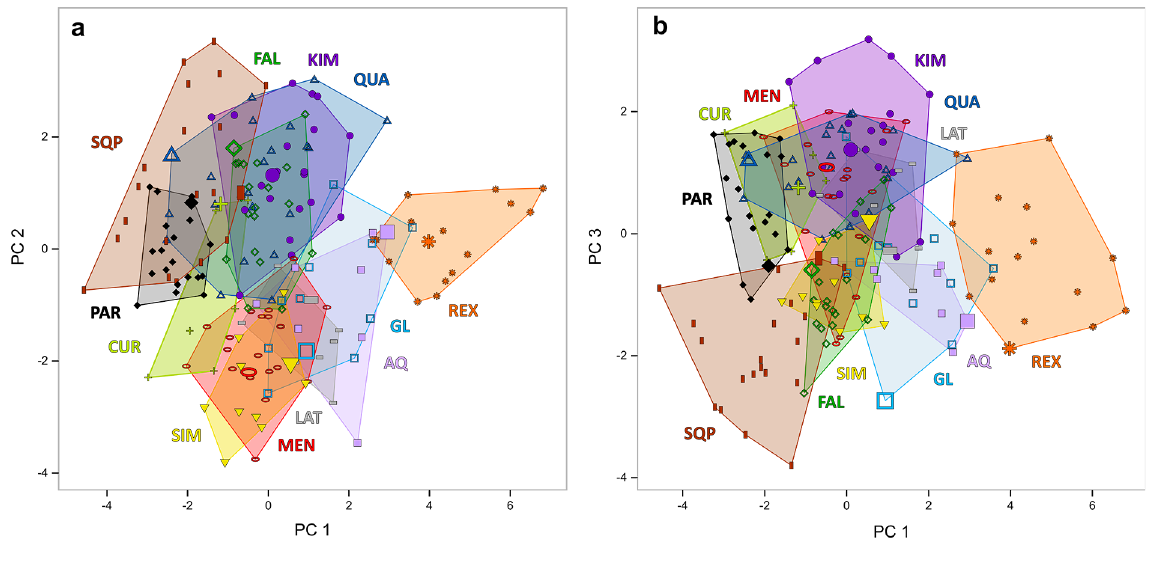
Fig. 4. Plots of a principal component analysis of 21 counts of 12 groups of Haplochromis from the Lake Edward system with a piscivorous morphology: H . sp. ‘latifrons’ ( ), H . mentatus Regan, 1925 ( ), H . sp. ‘rex’ ( ), H . sp. ‘simba’ (▼▼), H . sp. ‘glaucus’ (■), H . sp. ‘aquila’ (■■), H . sp. ‘kimondo’ (●●), H . sp. ‘falcatus’ ( ), H . sp. ‘curvidens’ ( ), H . sp. ‘pardus’ ( ), H . sp. ‘quasimodo’ ( ▲ ), and H . squamipinnis Regan, 1921 ( ██ ); holotypes are indicated by larger